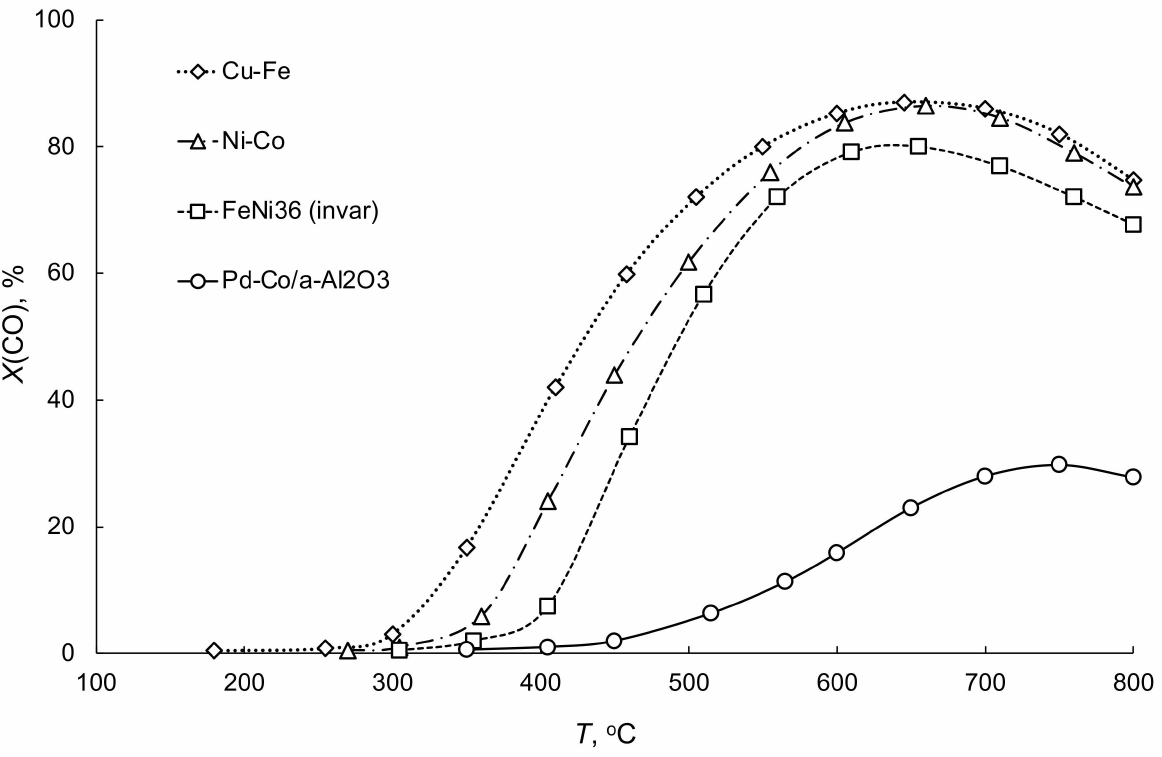
Figure 4. Temperature dependence of carbon monoxide conversion in water–gas shift reaction in porous catalytic converters of variable composition.